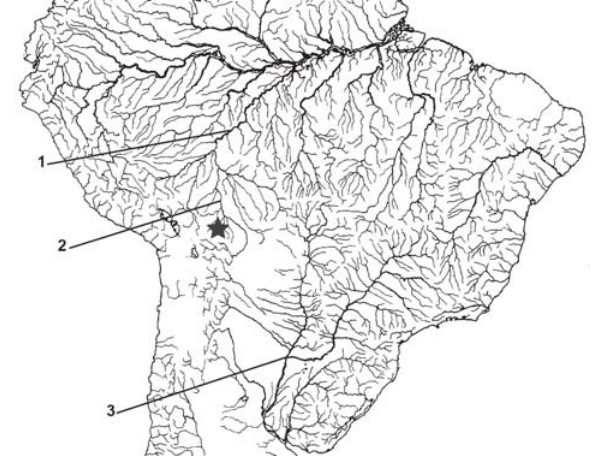
Fig. 3. Map of South America, star indicates the approximate position of the type locality of Knodus shinahota ; 1, rio Madeira; 2, rio Mamoré; 3, rios